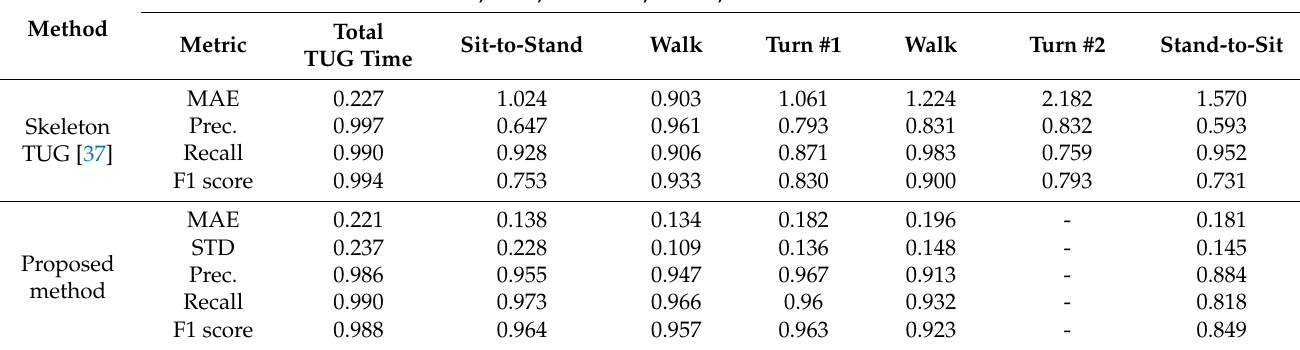
Table 5. Comparison for TUG subtask segmentation for older